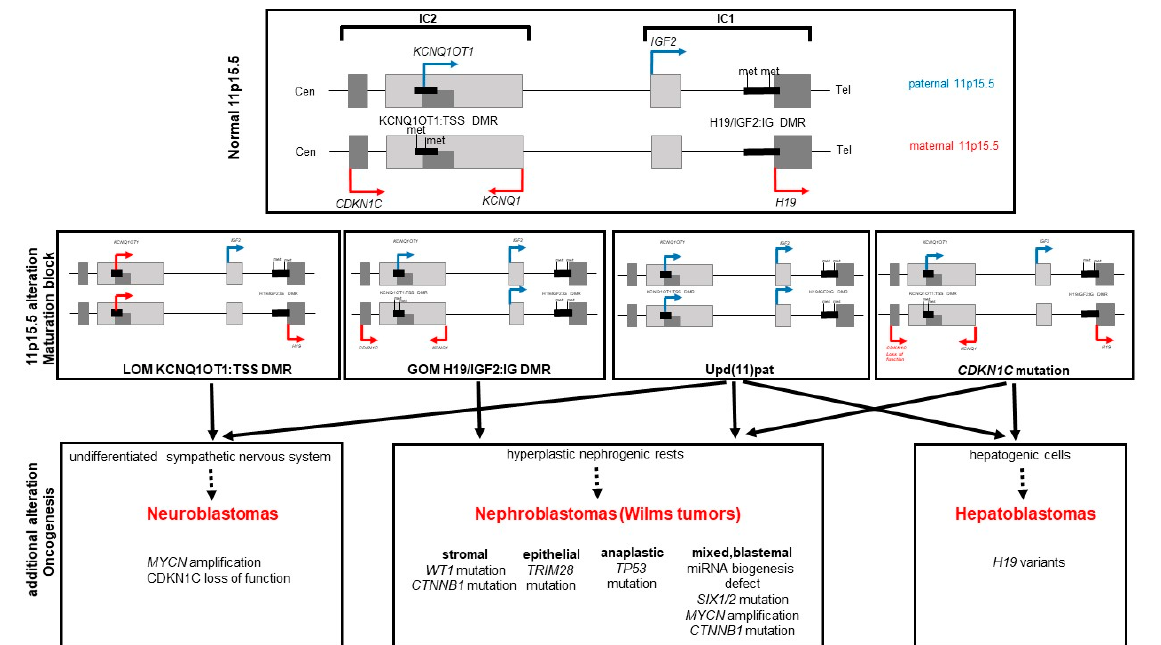
Figure 1. Schematic representation of genetic and epigenetic defects causing BWSp and tumor types associated with the specific defects. Upper Panel: Schematic delineation of the chromosomal region 11p15.5 with the two imprinting clusters IC1 and IC2, the allele-specific methylation of the respective DMRs and the consequent expression of imprinted genes on the maternal (red) and paternal (blue) allele. Middle Panel: Defects observed in BWSp patients with resulting transcriptional consequences, leading to a maturation block in cells of susceptible organs. These cells may persist after birth and then either terminate their differentiation, regress or progress to form hyperplastic and tumorigenic cells. Lower Panel: Tumor types and histological subclasses that occur with certain risk due to typical secondary mutations in the cells that were stalled in development.